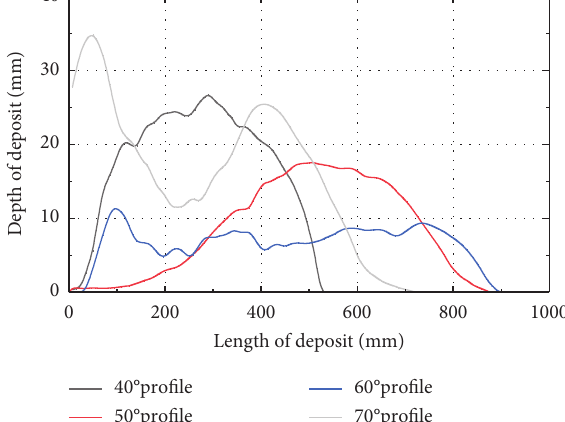
Figure 10: The deposit profiles of flowslides at different angles.